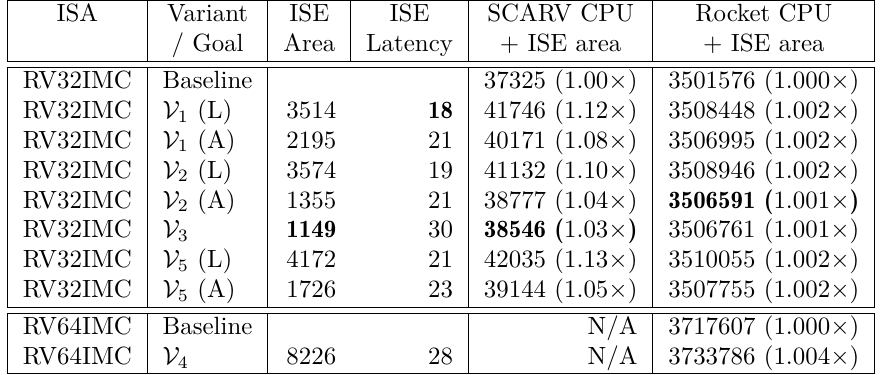
Table 1: Hardware metrics for each ISE variant with encrypt and decrypt instructions. Area is measured in NAND2 gate equivalents and latency in gate delays.